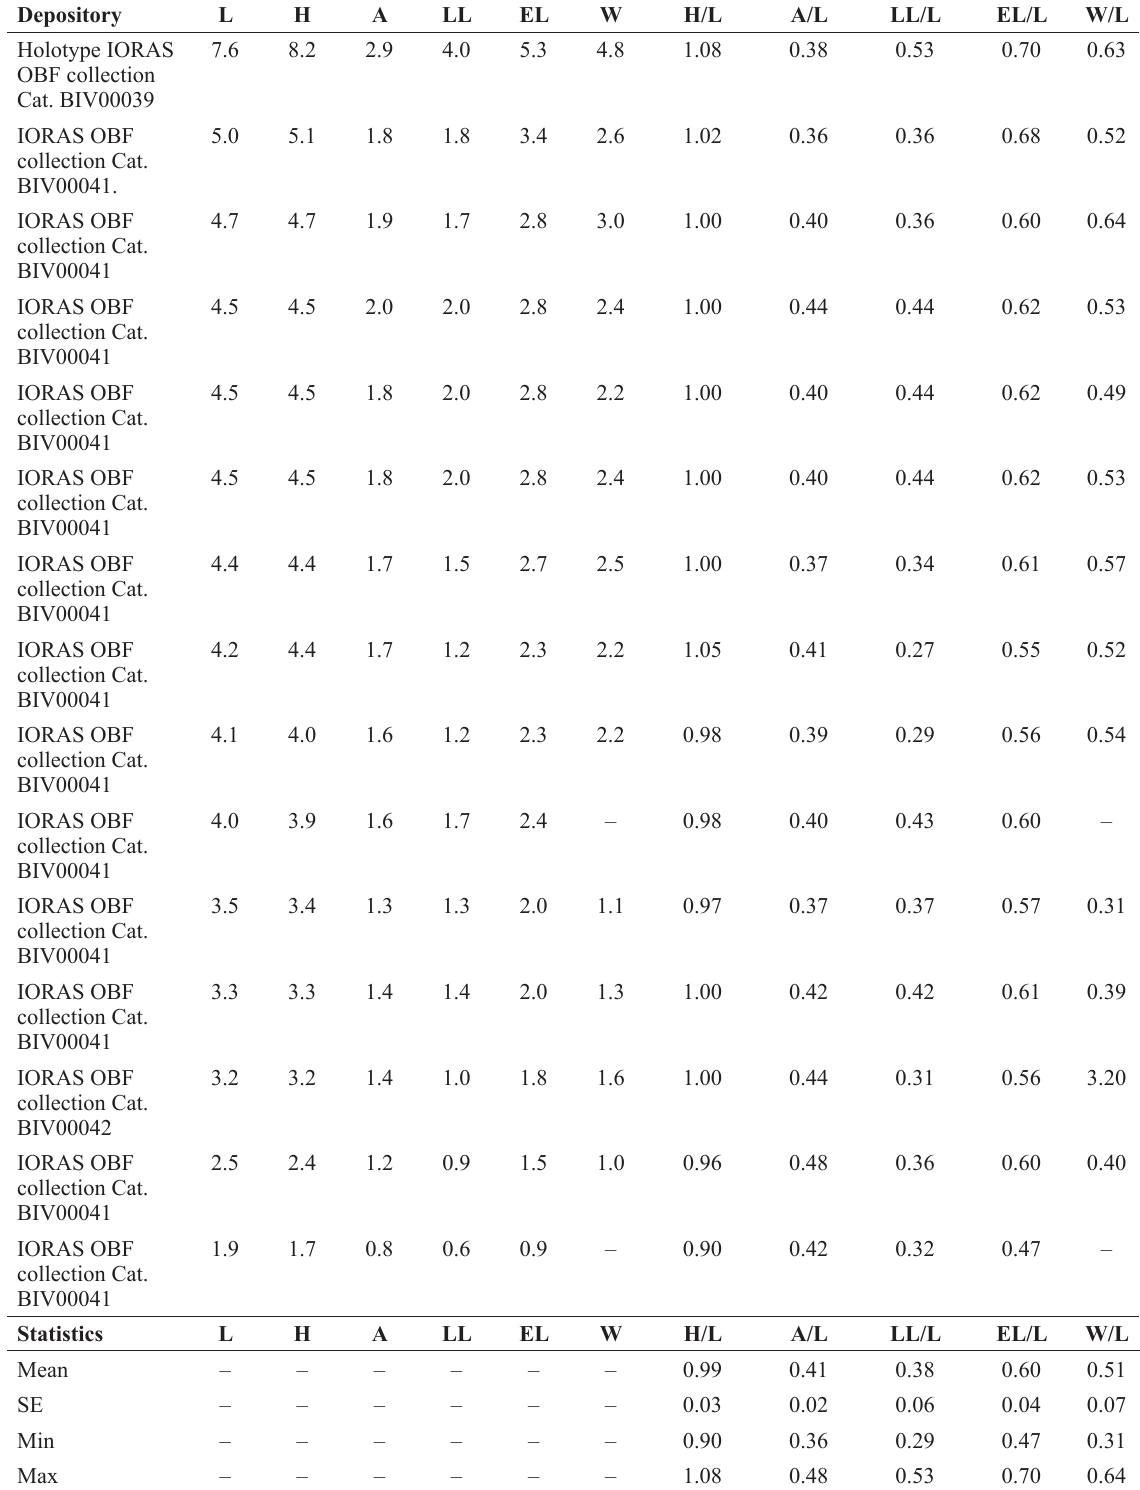
Table 3. Parathyasira pauli sp. nov., shell measurements (mm), indices and summary statistics of